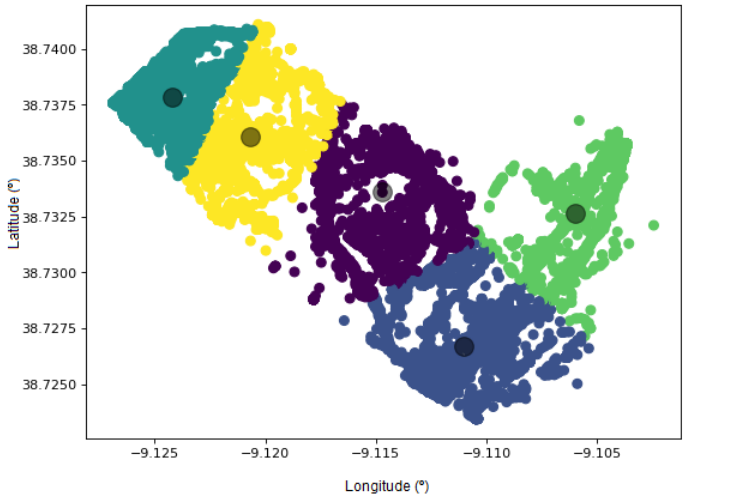
Figure 16. K-Means centroids output for Beato.